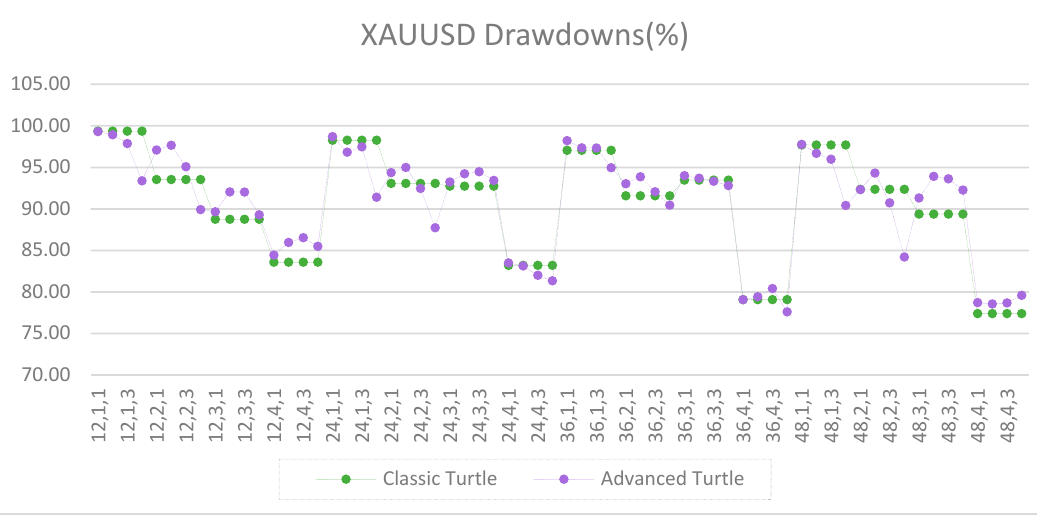
Figure A28. Drawdowns of XAUUSD as percentage of equity between the classic and the advanced Turtle systems for every combination of N, X, Y for the medium parameters (40, 80).